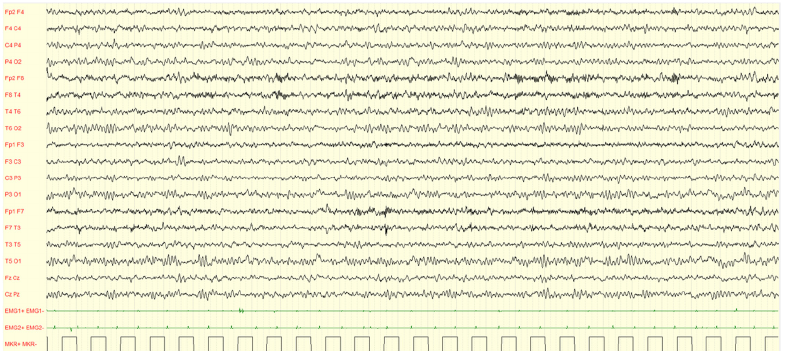
Figure 3. Male, 4 years PSG-EEG: background activity in wakefulness characterized by abundant rapid rhythms on the anterior regions.